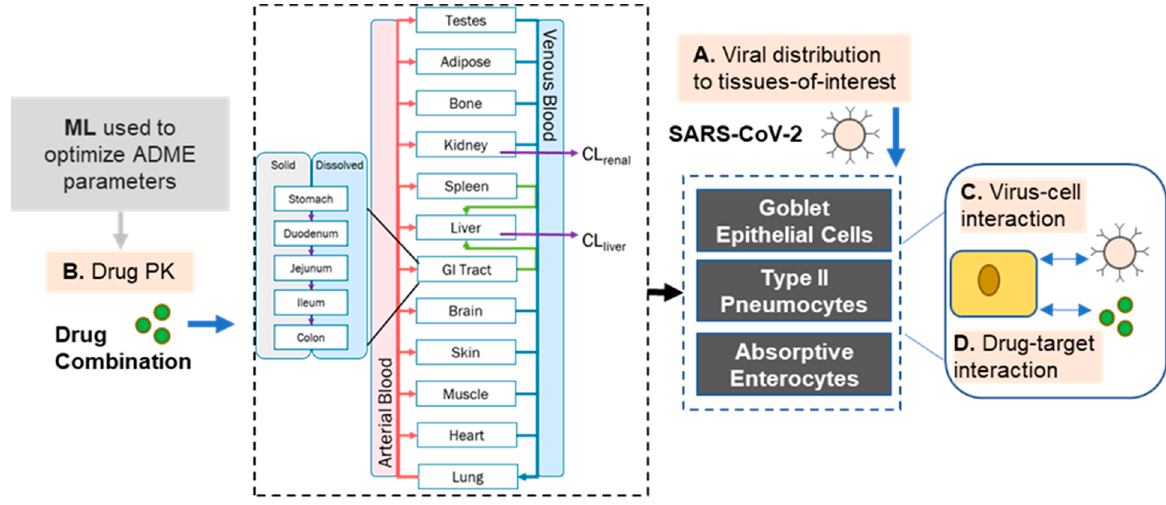
Figure 6. Diagram of modeling approach taken that extends beyond pharmacokinetic modeling of compound disposition and can explore more complex viral and combination effects.